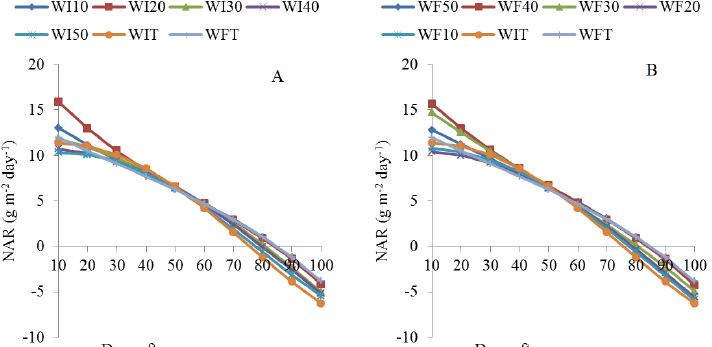
Fig. 5. Dry bean net assimilation rate (NAR) trend over time at different treatments of weed interference (A) and weed free (B) periods. WI10, WI20, WI30, WI40 and WI50: weed infested periods until 10, 20, 30, 40 and 50 days after crop emergence, respec- tively; WF10, WF20, WF30, WF40 and WF50: weed free periods until 10, 20, 30, 40 and 50 days after crop emergence, respec- tively; WIT and WFT: weed competition and weed control throughout growing season,